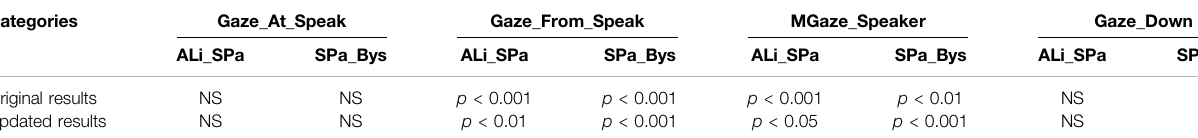
TABLE 2| The fi rst row ofthistablestates the results oftheposthoc test, asoriginallyreportedin Oertel et al.(2015). The second row ofthis table indicates theresults ofthe posthoc test after having added the extra samples speci fi cally for this article. It can be observed that the signi fi cant differences between listener categories did not change.